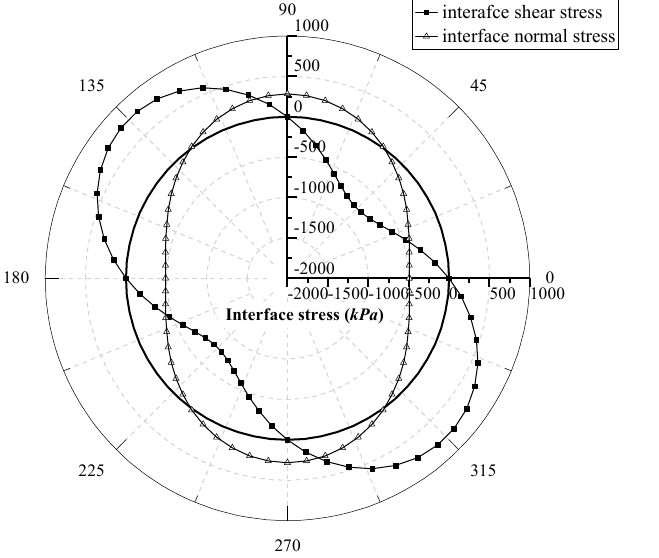
Figure 13. Interface stress distributions of the tunnel with and without steel plate strengthening.